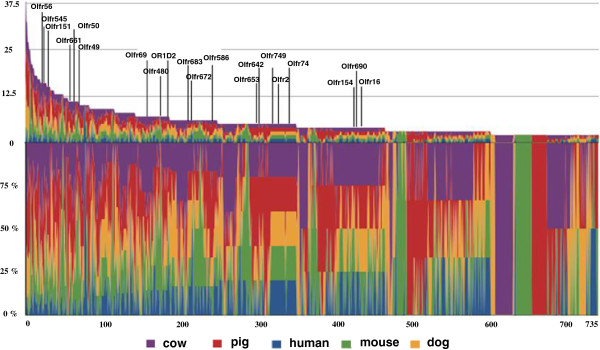
Comparison of OR gene similarity among humans, dogs, mice, pigs, and cattle by clustering analysis of OR genes on the basis of amino acid sequence similarity. The Y-axis of the upper graph shows the number of OR genes in each cluster ranging from 2 to 43 genes. The X-axis of the lower graph indicates the cluster number, with 751 clusters. The Y-axis of the lower graph indicates the percentage of OR genes of each species within the cluster. The OR genes of different species are indicated by different colors.